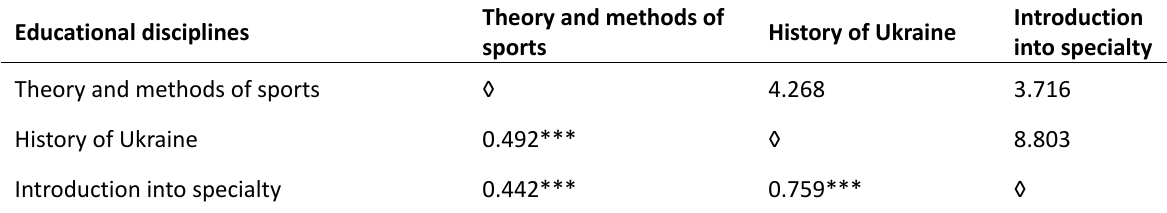
Table 3. Correlation table of the educational disciplines scores on the semester control of 1 st year: r-Pearson \ t-Student Educational